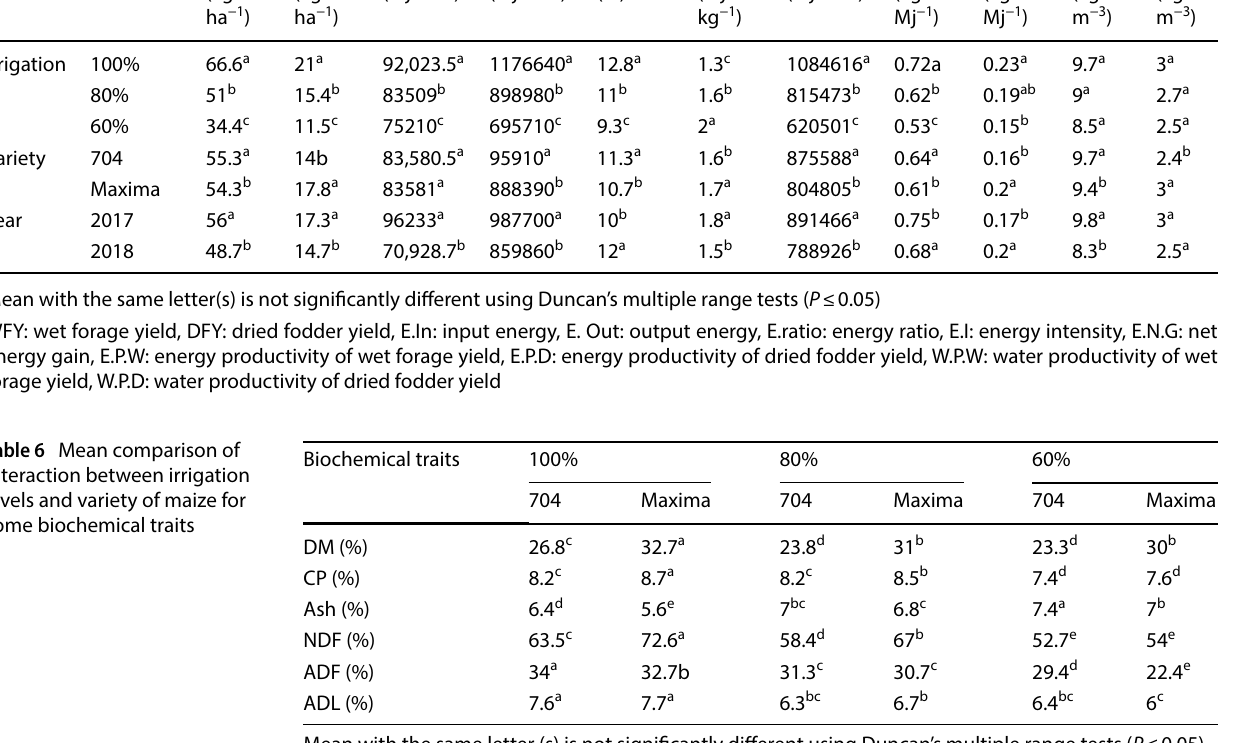
Table 5 Mean comparison of irrigation levels and variety of maize for yield and energy traits